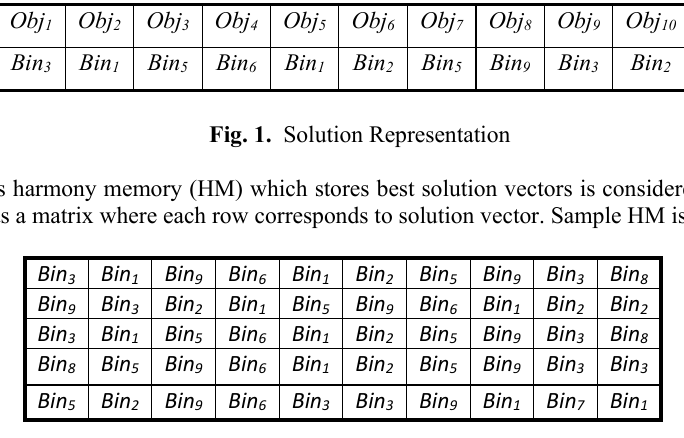
Fig. 2. Sample harmony memory